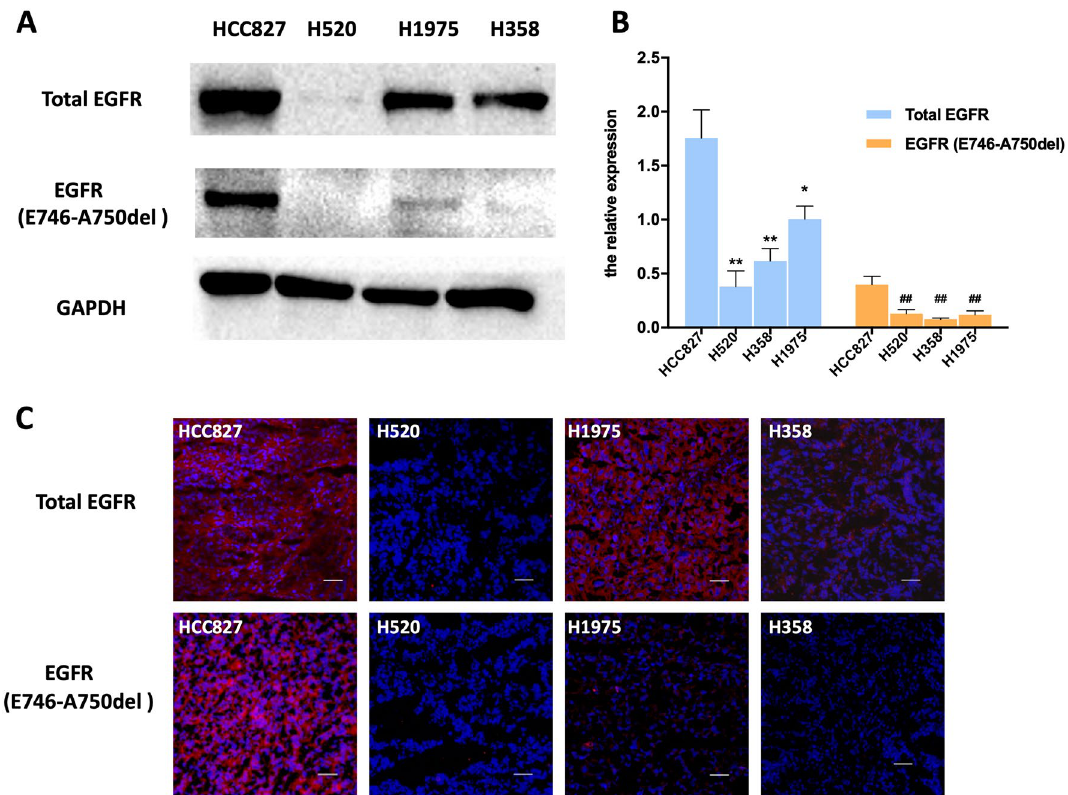
Figure 5. Western blot and immunofluorescence of tumors derived from HCC827, H520, H1975 and H358 cell lines. ( A ) Representative Western blots of four human NSCLC tissue lysates comparing the extent of EGFR and EGFR-specific E749-A750del mutation expression. GAPDH served as a reference for equal loading. HCC827 tissue has high EGFR and EGFR-specific E749-A750del mutation EGFR ( B ) Western blot analysis of proteins in total EGFR and EGFR-specific E749-A750del mutation (n = 3). Data are presented as mean ± SD. * P < 0.05 vs. HCC827 group in total EGFR. ** P < 0.01 vs. HCC827 group in total EGFR. ## P < 0.01 vs. HCC827 group in EGFR-specific E749-A750del mutation. ( C ) The immunofluorescence in tumors confirms western blot results. (Red color is from secondary antibody Alexa Fluor®549, and blue color from DAPI for nuclear visualization). All scale bars, 100